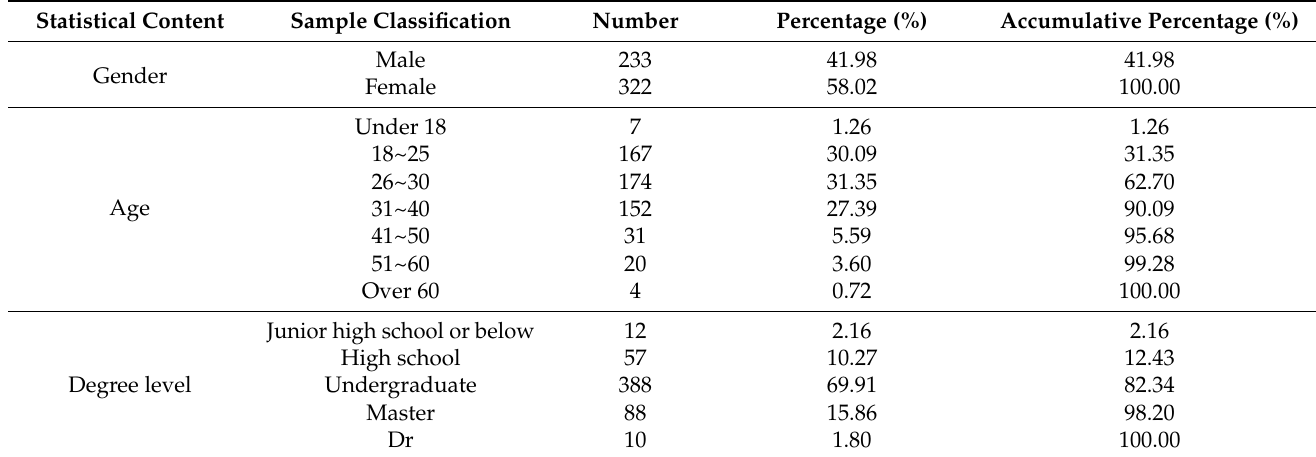
Table 6. Demographic data analysis of the scale measurements.